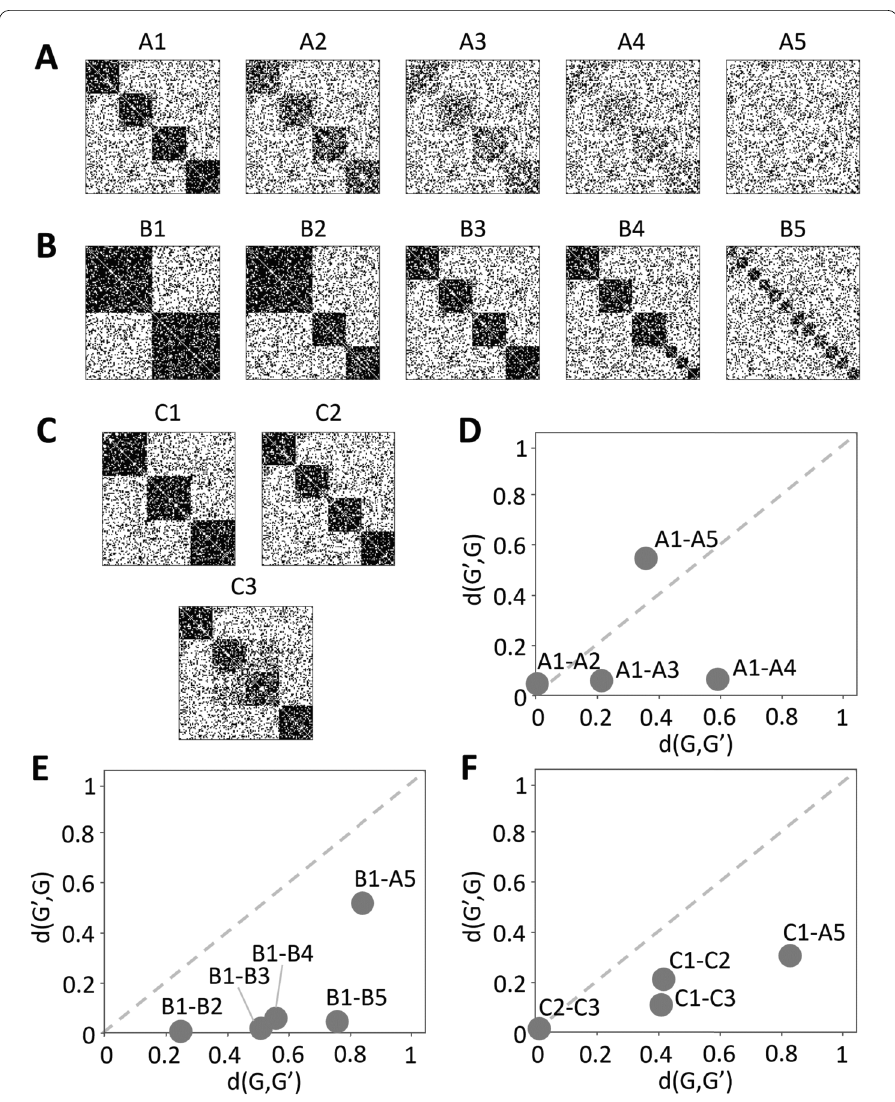
Figure 3 We illustrate our framework using three different families of SBMs. In family A all five networks contain the same communities, but the strength of in-group ties is sequentially decreasing. In subfigure ( D ) we see that the distances are zero whenever the original communities are detected, and increase with the weakening of the community structure. In family B each successive SBM is a refinement of the previous one, with blocks splitting along the way. So while B1 has two large communities, B3 has 4 communities, two for each of B1’s communities. Notice that in subfigure ( E ), the community structure of B1 describes well the structure of B2–B5, but that doesn’t hold in the other direction. In the last family of SBMs C1 has three communities while C2 and C3 have four identical communities. But for C2, two of these communities can also be merged into one larger community. In subfigure ( F ) we can see that, while C2 and C3 have an identical optimal community structure, our method picks up that C1 is closer to C3 than to C2 because C3 can also